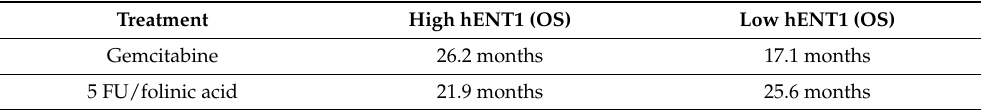
Table 1. Role of hENT1 expression on effectiveness of Gemcitabine and 5-FU/folinic-acid adjuvant therapy on overall survival in PDAC patients (Greenhalf et al.)